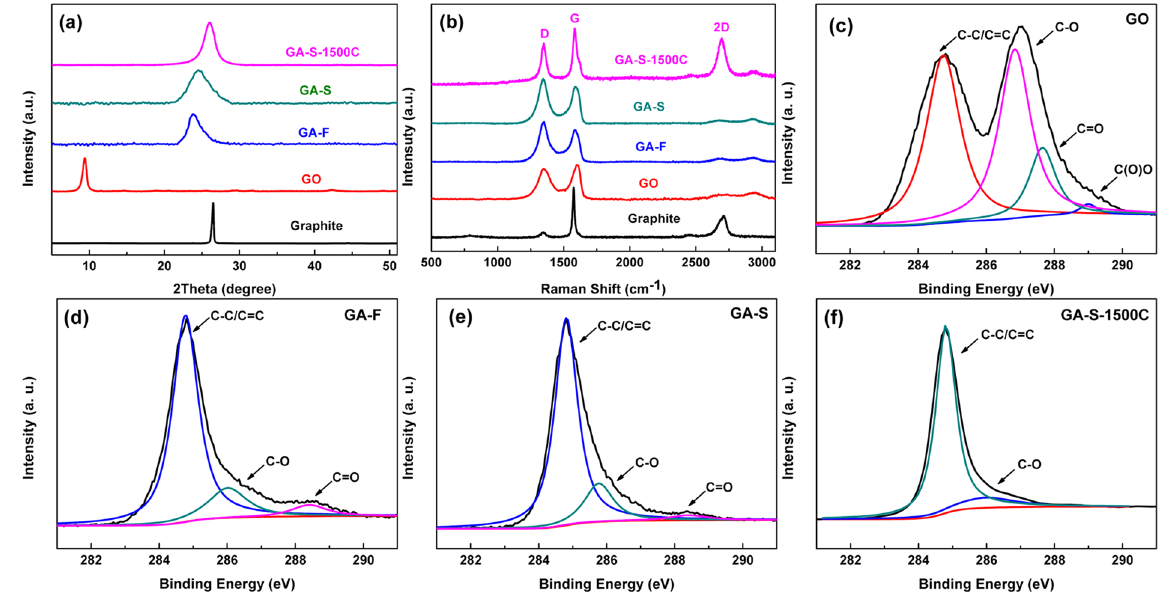
Figure 4. ( a ) X-ray diffraction patterns and ( b ) Raman spectra of graphite, GO, GA-F, GA-S, and GA-S-1500C. The C 1 s peak in the X-ray photoelectron spectra of ( c ) GO, ( d ) GA-F, ( e ) GA-S, and ( f )